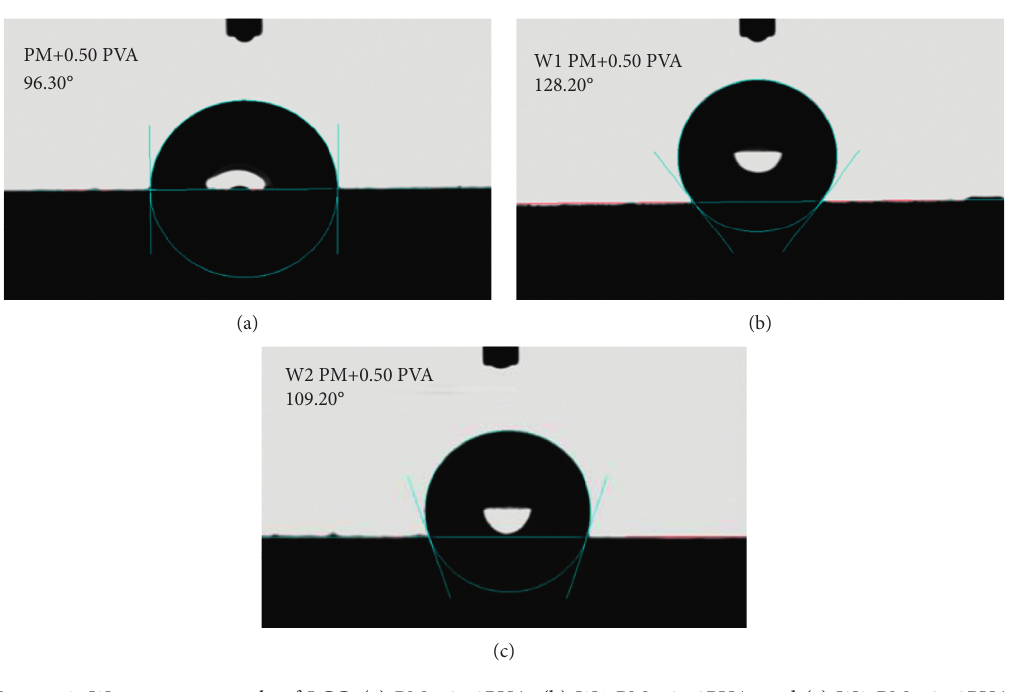
Figure 9: Water contact angle of LCC. (a) PM+0.50PVA, (b) W1 PM+0.50PVA, and (c) W2 PM+0.50PVA.